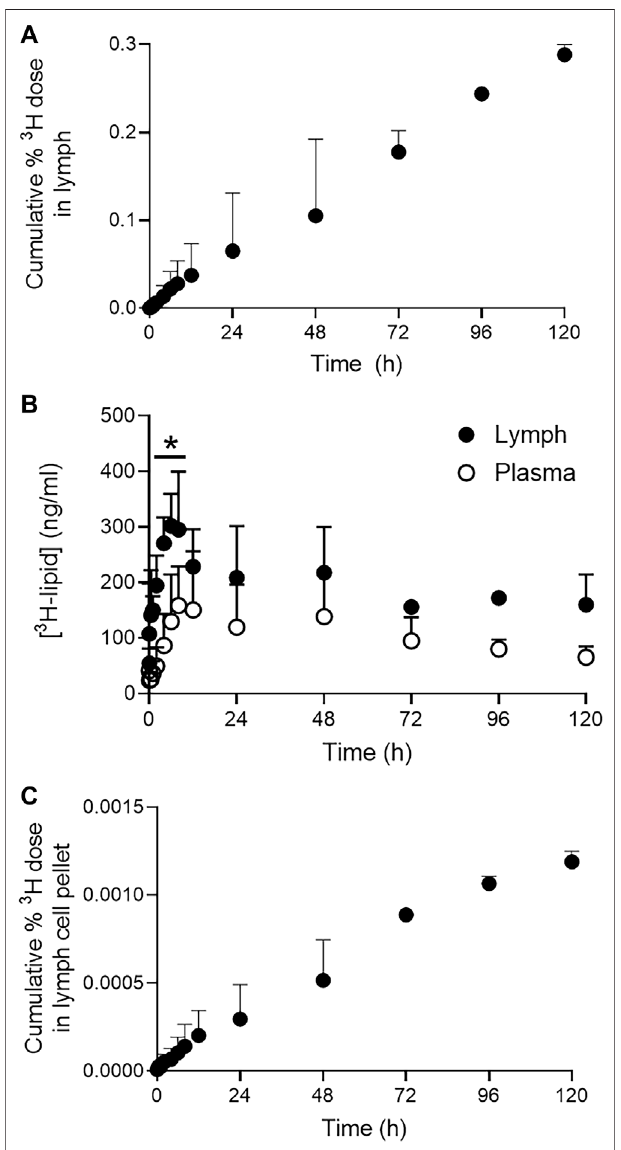
FIGURE 3 | Pulmonary lymphatic pharmacokinetics of 3 H-lipid in CMLD-cannulated sheep after nebulized administration of 3 H-liposomes. (A) Cumulative recovery of dosed 3 H-lipid in CMLD lymph after pulmonary administration. (B) Comparative concentrations of 3 H-lipid in collected lymph ( black circles ) and plasma ( open circles ). Concentrations in plasma and lymph were normalized to a dose of 1 mg/kg. (C) Cumulative recovery of dosed 3 H-lipid in lymph cell pellets after pulmonary administration. Data representsmean ±SD ( n = 4). * P < 0.05between samples at each timepoint via two-way ANOVA with Sidaks Multiple Comparison